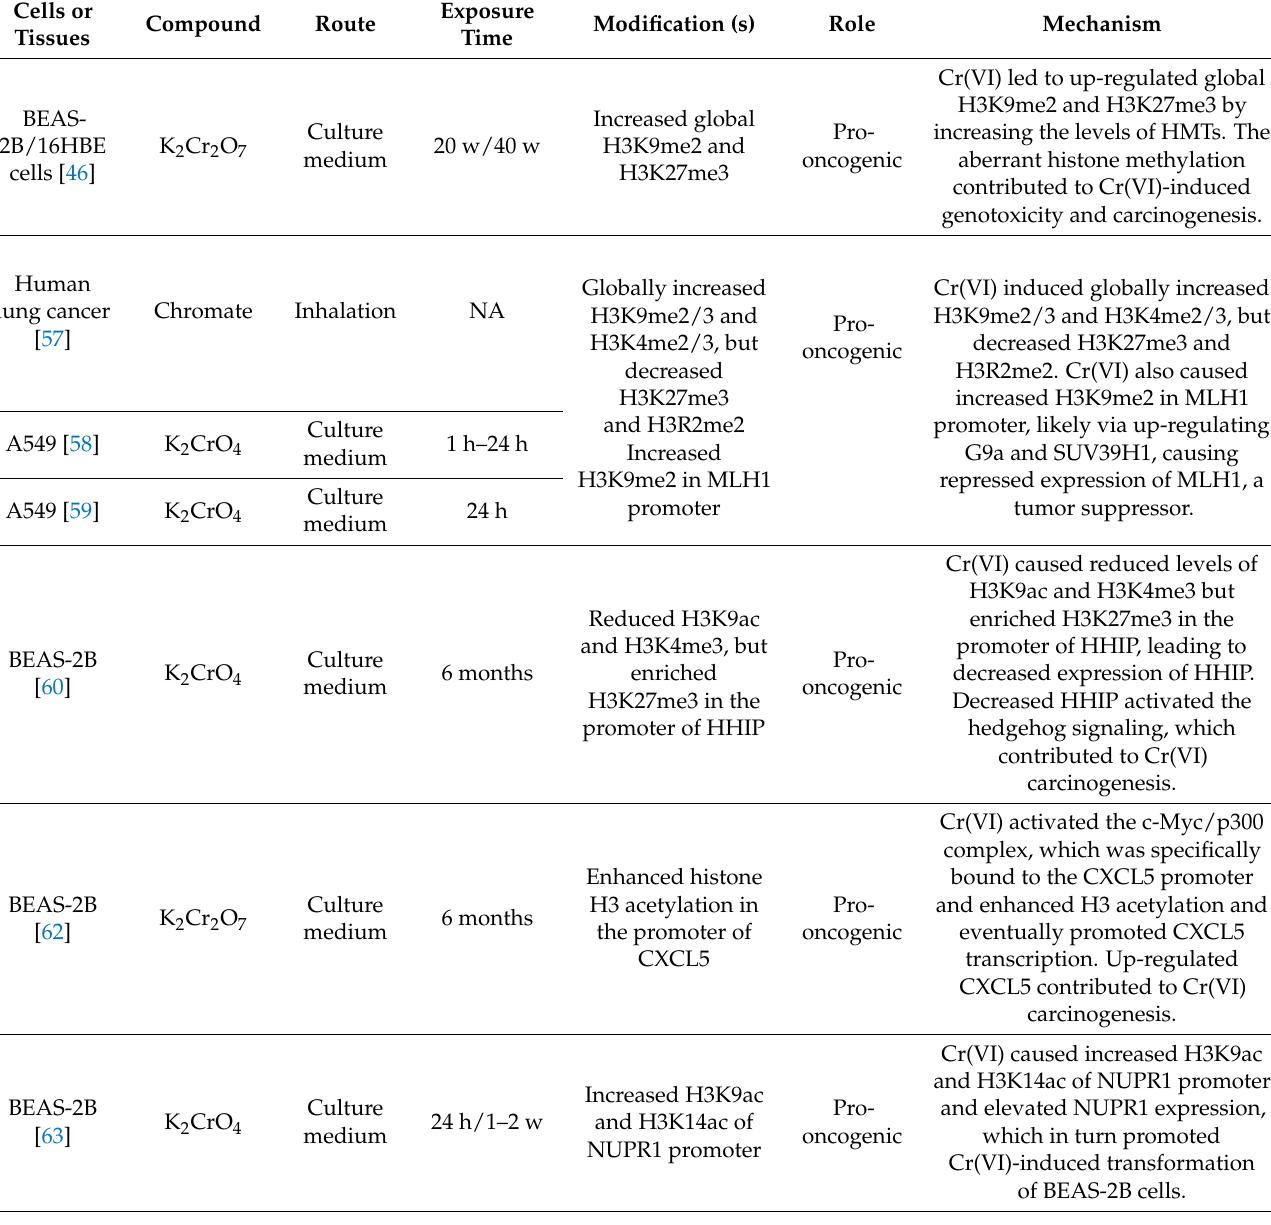
Table 2. Roles of histone modifications in Cr(VI) exposure-induced